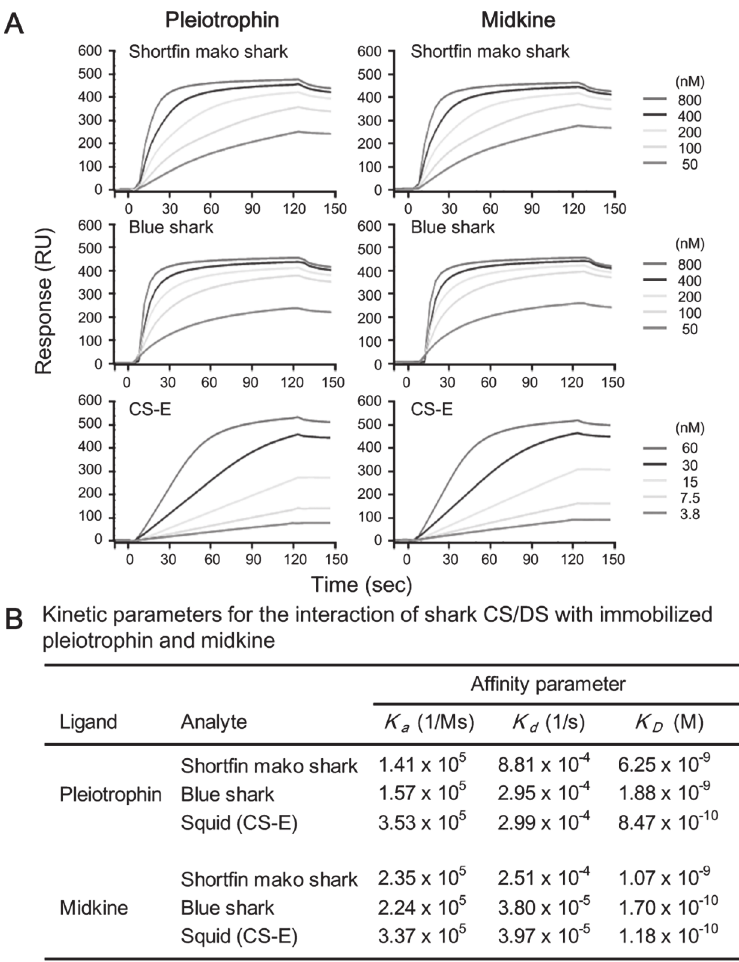
Fig 4. Binding of CS/DS from shortfin mako shark (Fr. 5) and blue shark (Fr. 3) to immobilize to growth factors. Various concentrations of shark CS/DS and squid CS-E (Seikagaku Corp., Tokyo, Japan) were injected onto the surface of a pleiotrophin- or midkine-immobilized sensor tip. Sensorgrams obtained with various concentrations of each shark CS/DS were evaluated using BIAevaluation 3.0 software. RU, resonance